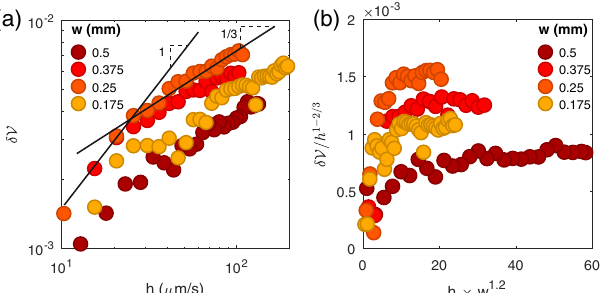
FIG. 7. Nonlinear response of a polar liquid flowing in the same direction as the external field. (a) The increase of δ V ≡ j V ð h Þ − V ð h ¼ 0 Þj is linear at small h and consistent with a h 1 = 3 scaling at high h . This behavior is compatible with the theoretical predictions of Ref. [15] based on renormalization group calcu- lations. (b) Finite-size scaling of δ V ð h; W Þ . Unlike what would be expected from the RG theory of Ref. [15], all plots do not collapse on the same master curve.